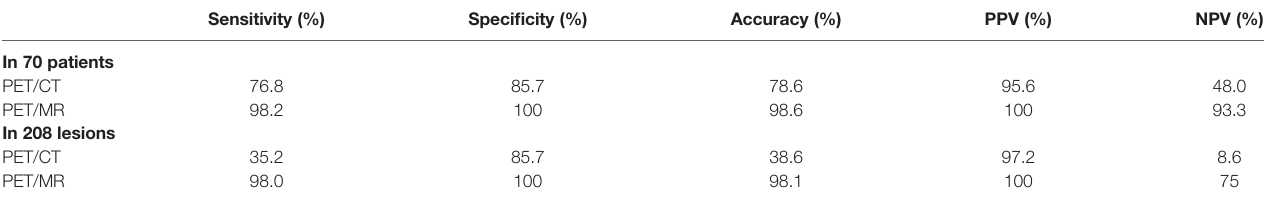
TABLE 3 | Diagnostic effectiveness of PET/CT and